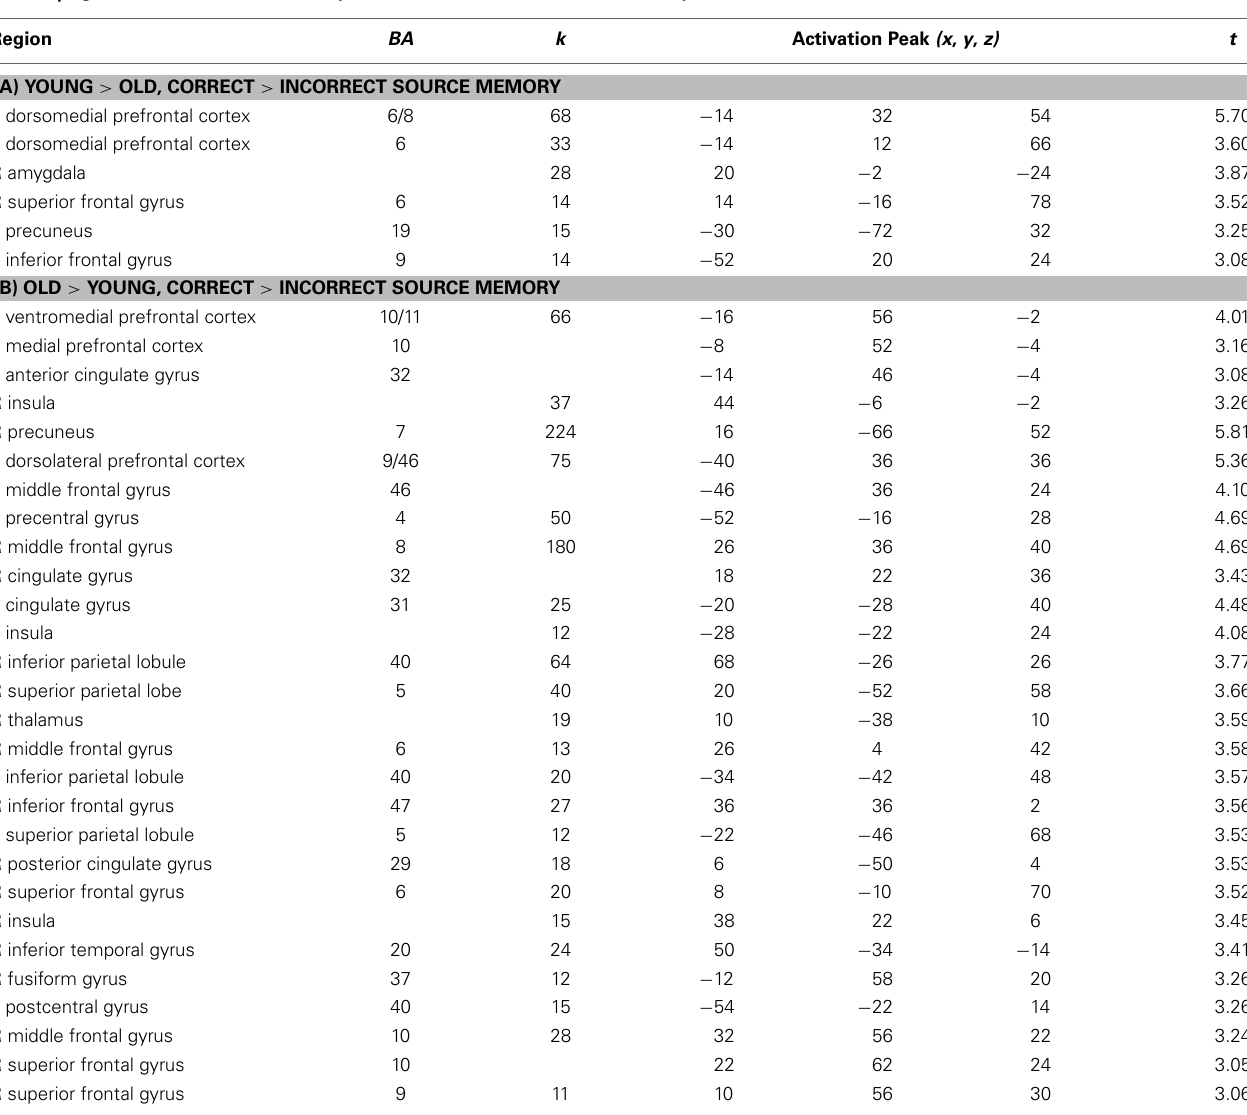
Table 3 | Age differences in brain activity for correct > incorrect source memory. Region BA k Activation Peak (x , y , z)